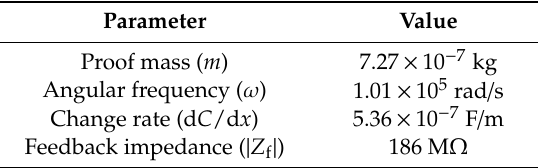
Table 3. System parameter of the DRG.